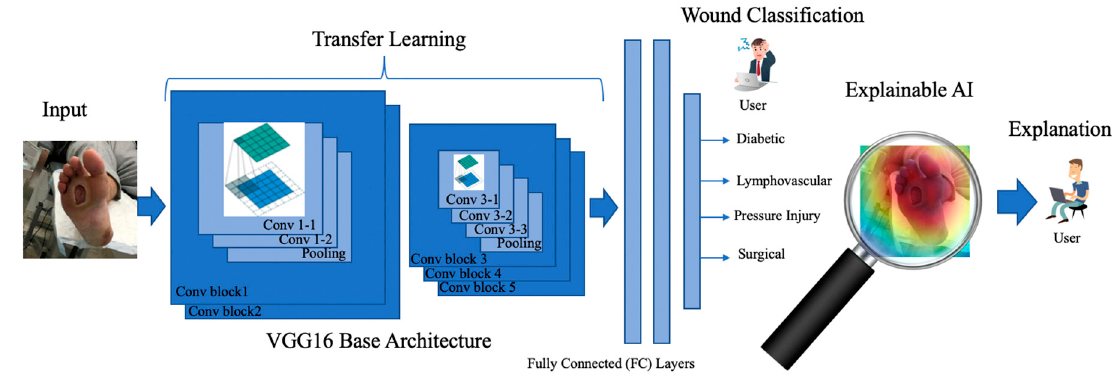
Figure 2. Wound classification model with transfer learning, DNN, and explainable AI tool.